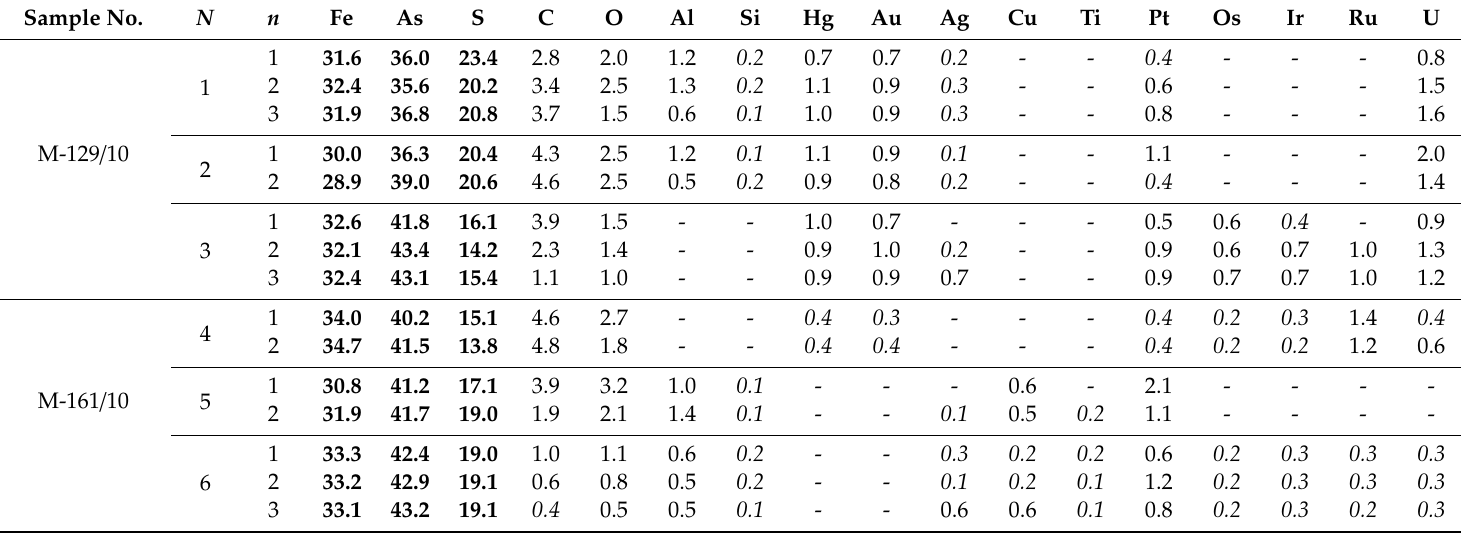
Table 8. Chemical composition (in wt%) of arsenopyrite crystal surfaces with micron-size rare inclusions of non-metallic minerals. Samples from vein ores of the Natalkinskoe